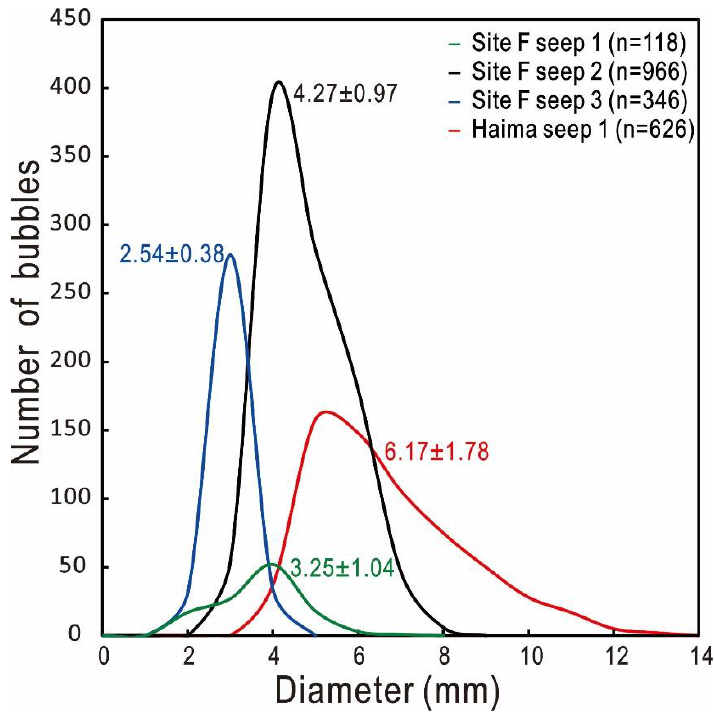
Figure 5. Average bubble size (with standard deviations) at Site F and Haima cold seeps.